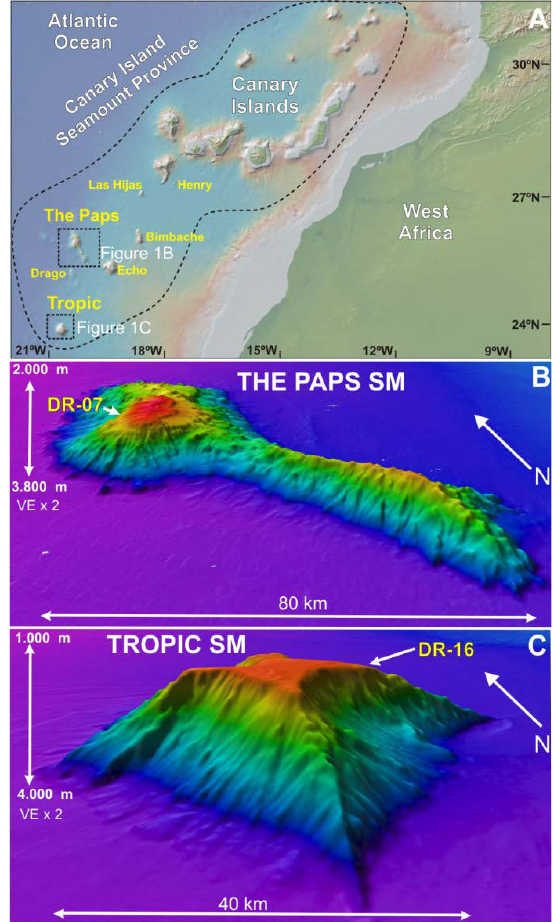
Figure 1. Regional setting of the Canary Islands Seamounts Province (CISP). ( A ) General view of the study area where the Canary archipelago and the most important seamounts of the southwest area of CISP are displayed; ( B , C ) Three-dimensional view produced with Fledermaus™ software and high-resolution bathymetry of the Tropic and The Paps seamounts. The position of the selected dredge hauls is indicated with arrows.